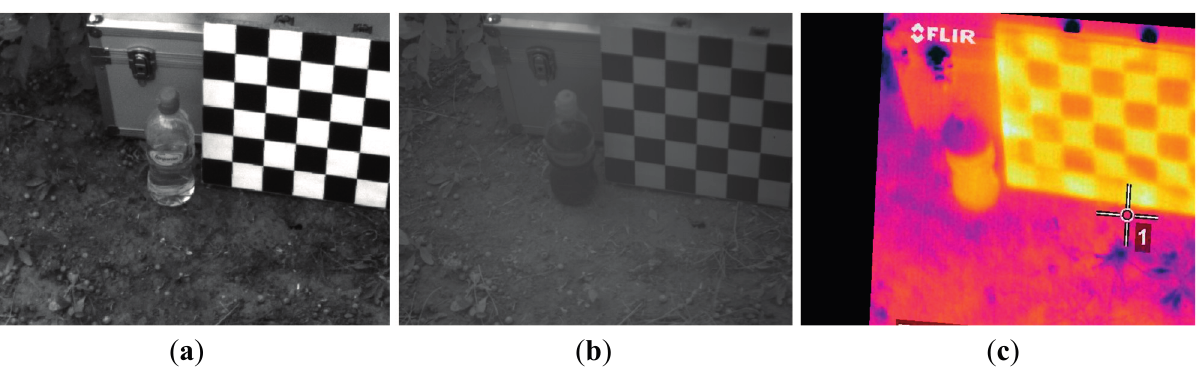
Figure 4. Images utilised as inputs for the registration procedure. ( a ) Monochrome image acquired by the AVT Prosilica GC2450; ( b ) SWIR image; ( c ) LWIR thermal image.